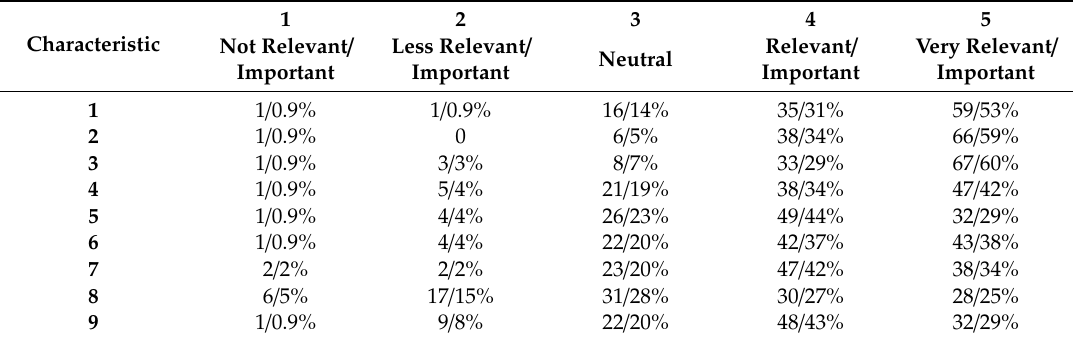
Table 1. Characteristics of a mentor.